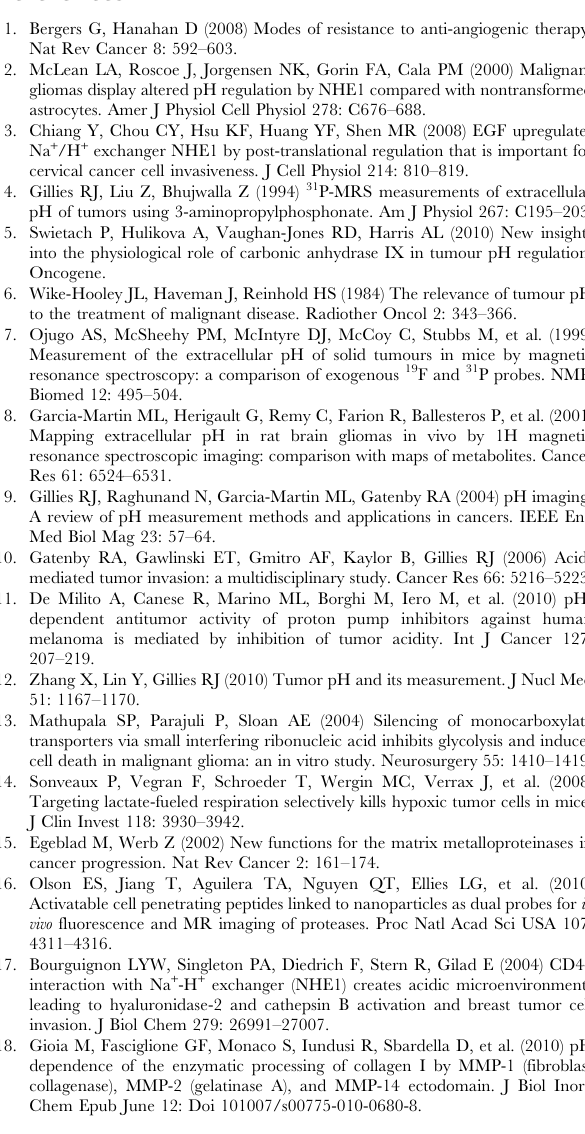
Figure S2 Specificity of the anti-NHE1 antiserum. (A) Western blot of antiserum 1950 on a protein extract of a brain bearing a C6 glioma showing bands at 95 and 65 kDa. (B) The preparation of CterNHE1-GST revealed with Coomassie blue in SDS-PAGE on a 10% gel (a) and revealed on Western blots by antiserum 1950 (b) and monoclonal antibody 4E9 (c). After depletion by the NHE1 construct, antiserum 1950 no longer detected the construct (d). Labeling of brain sections was more intense with undepleted antiserum 1950 (C) than with the depleted antiserum (D). Antiserum 1950 did not label the NHE3 isoform in PS 120 fibroblasts (E). WT fibroblasts transfected to express NHE1 show a band at the appropriate MWt (arrow), whereas this is not present for WT fibroblasts and fibroblasts transfected to express NHE3. Scale bars in (C,D) 100